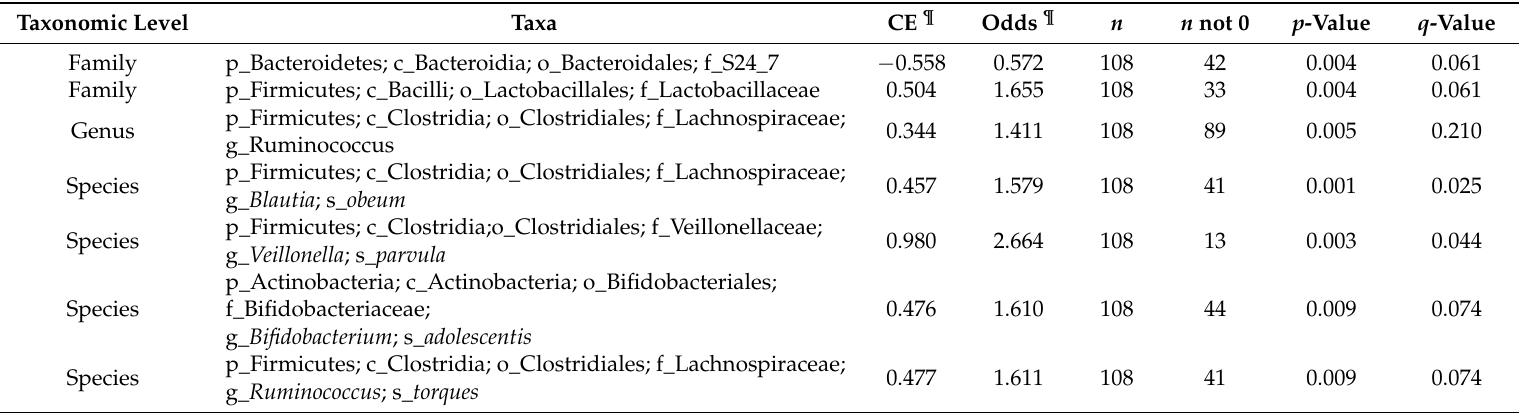
Table 3. Associations between cholecystectomy and gut microbiota composition using MaAsLin